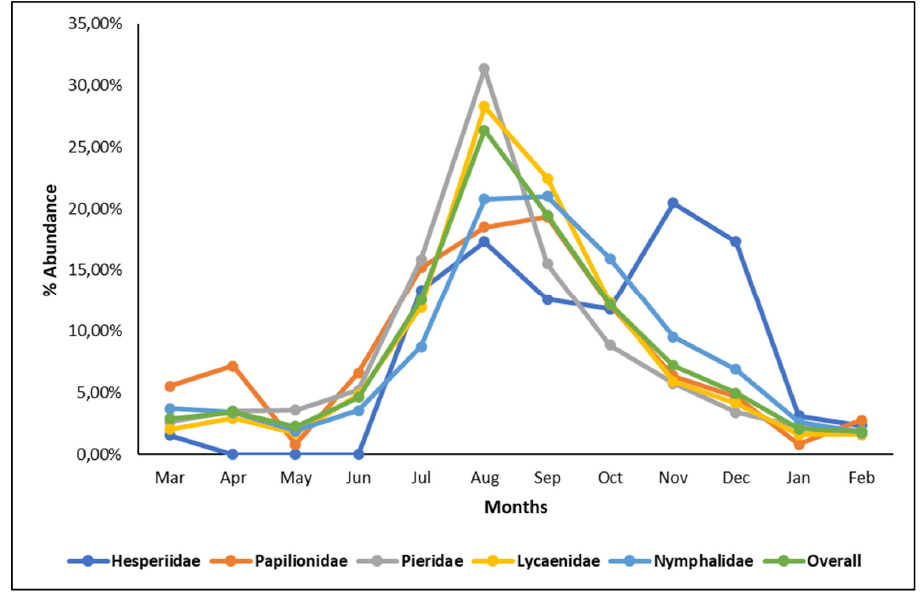
Figure 5. Family-wise abundance of butterfly species in the study